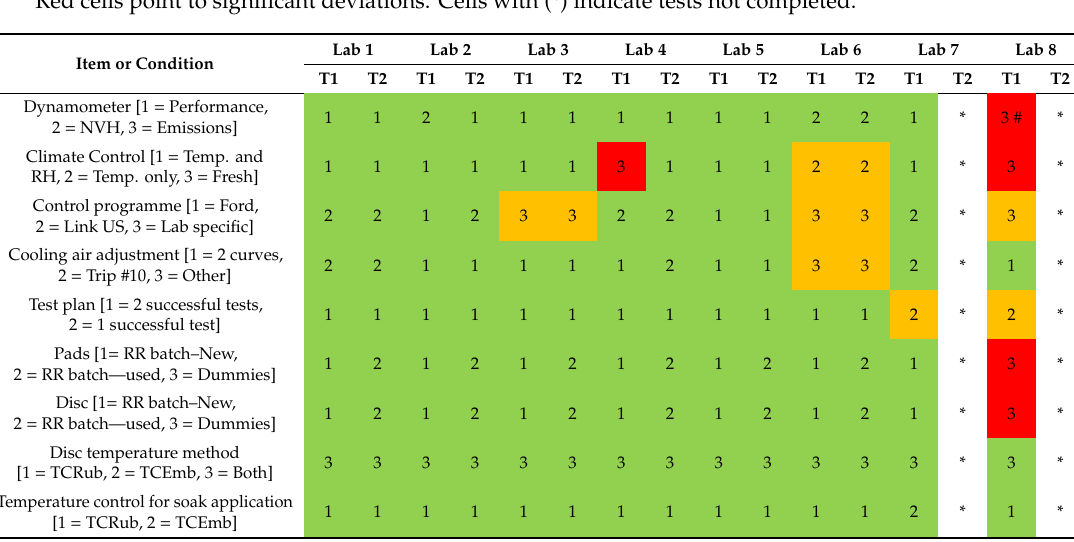
Table 1. Summary of the applied hardware and testing conditions—green cells indicate the lab followed the recommended method. Orange cells indicate the lab used an acceptable or equivalent method. Red cells point to significant deviations. Cells with (*) indicate tests not